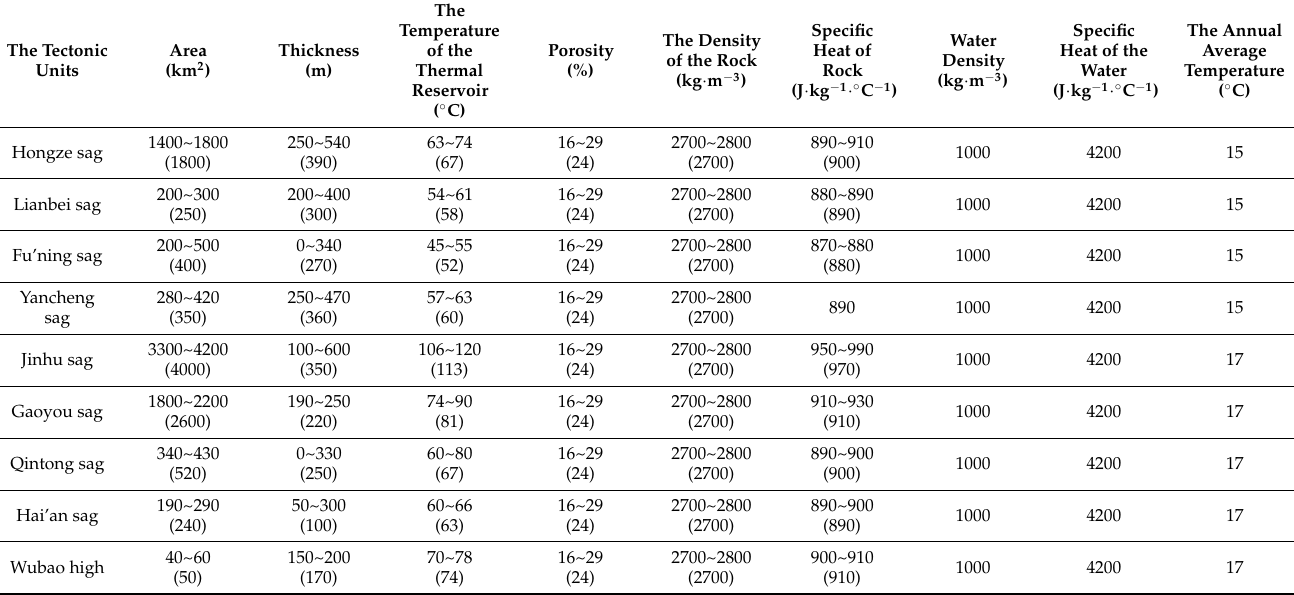
Table 4. Parameters for the Dai’nan Formation thermal